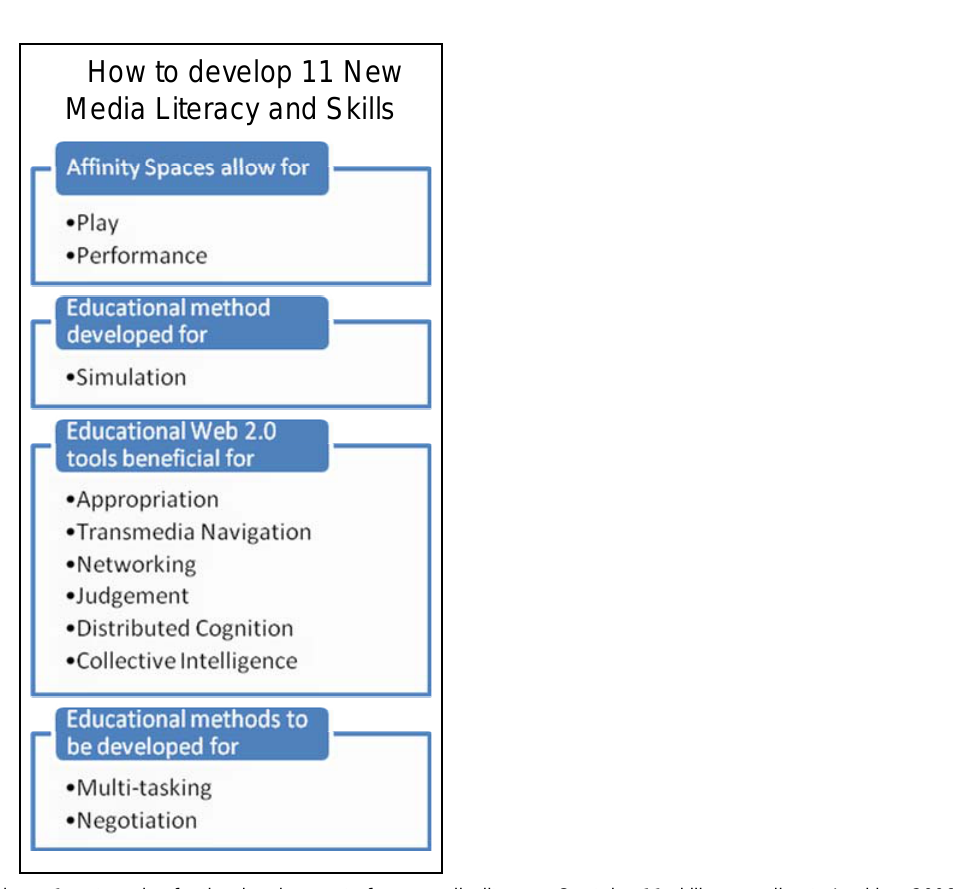
Figure 1: categories for the development of new media literacy. Contains 11 skills according to Jenkins,